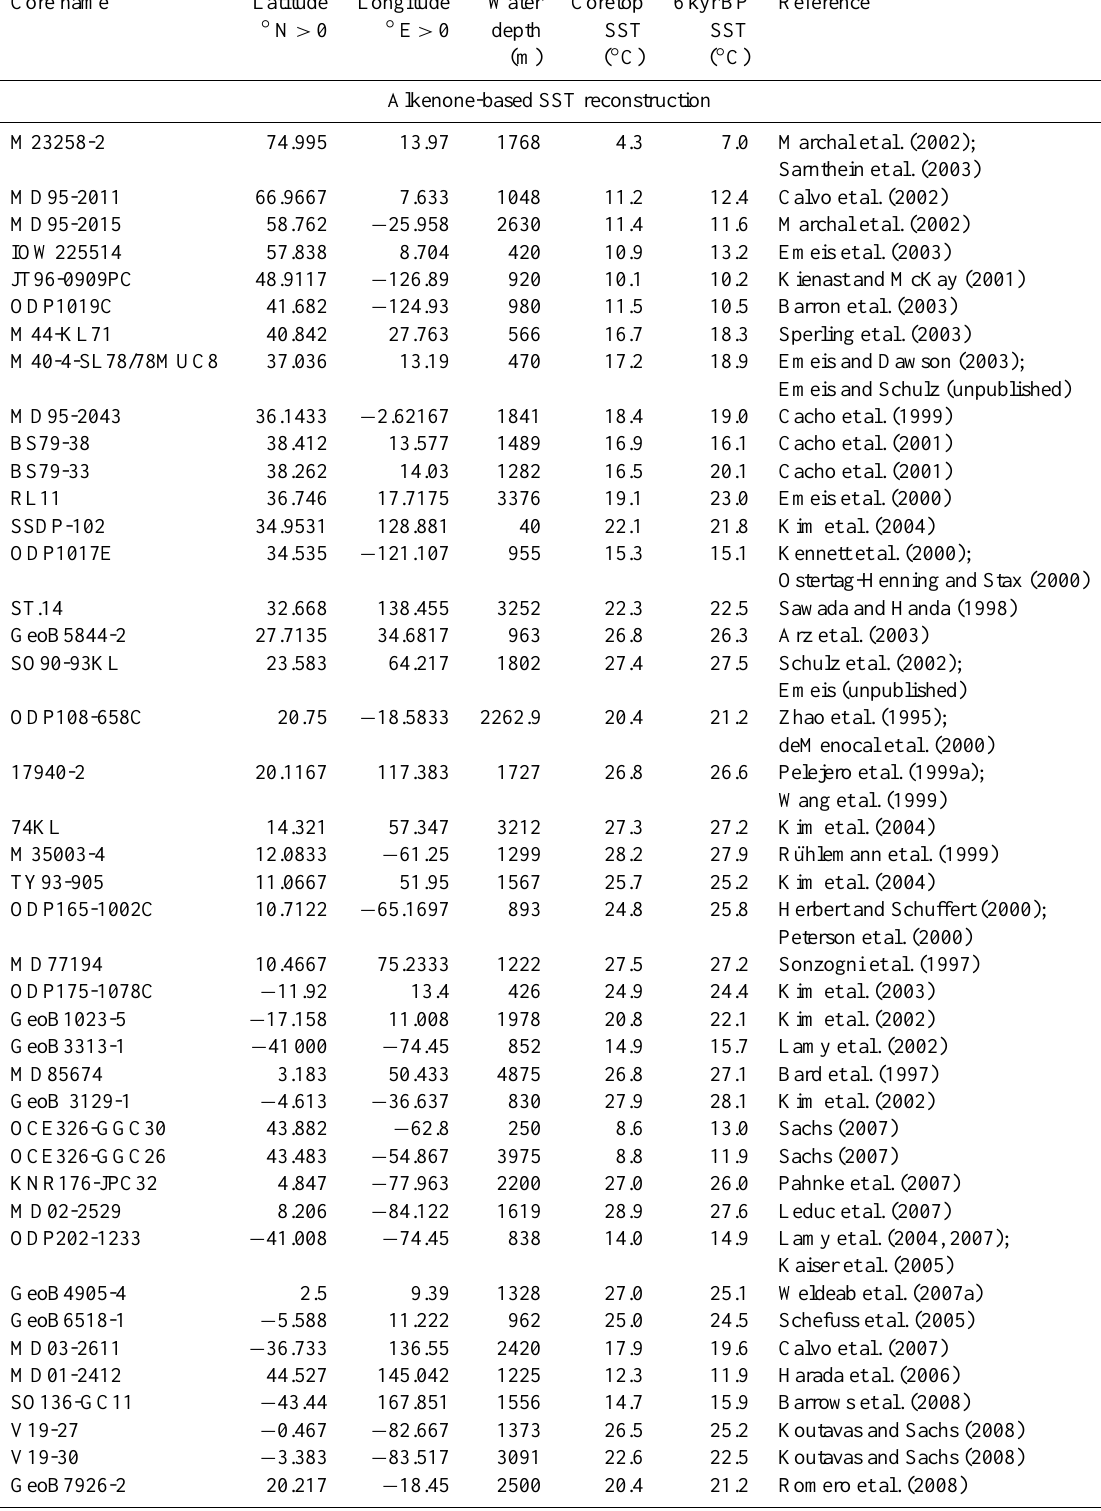
Table 1. List of alkenone and Mg/Ca records used in the paper. The data is available through http://doi.pangaea.de/10.1594/PANGAEA. 737370?offset=0#dslist, and the metadata for alkenone (http://doi.pangaea.de/10.1594/PANGAEA.737301) and Mg/Ca (http://doi.pangaea. de/10.1594/PANGAEA.736946) records is also